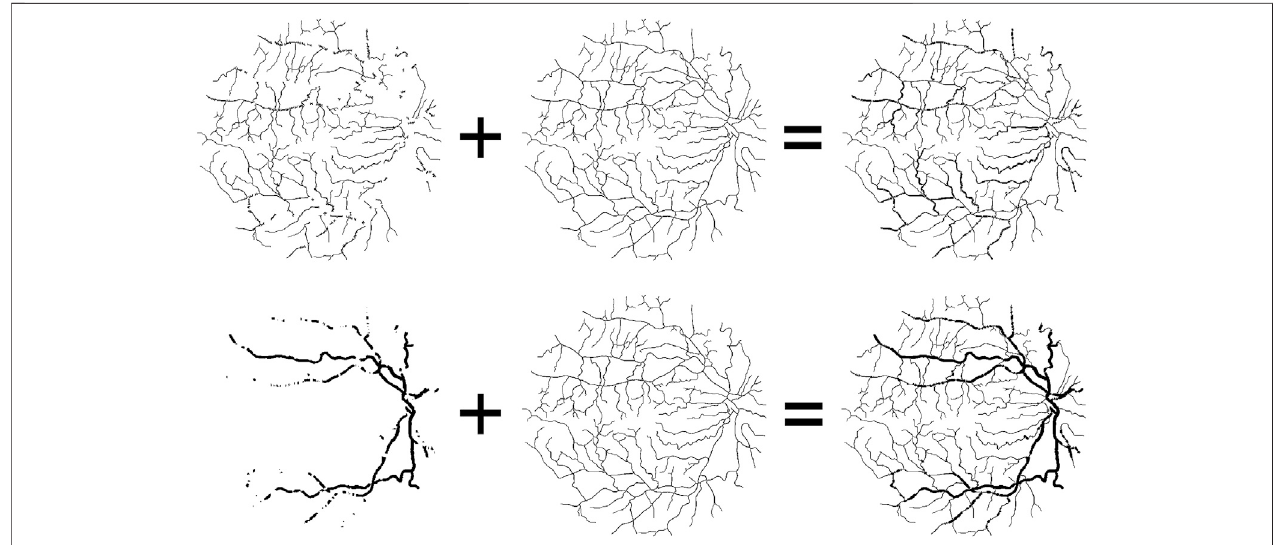
FIGURE 5 | Composition of thin and thick vascular training objectives. From the left to right: thin (or thick) vessel of original label image, the same vessel skeleton, and thin (or thick) training objectives.